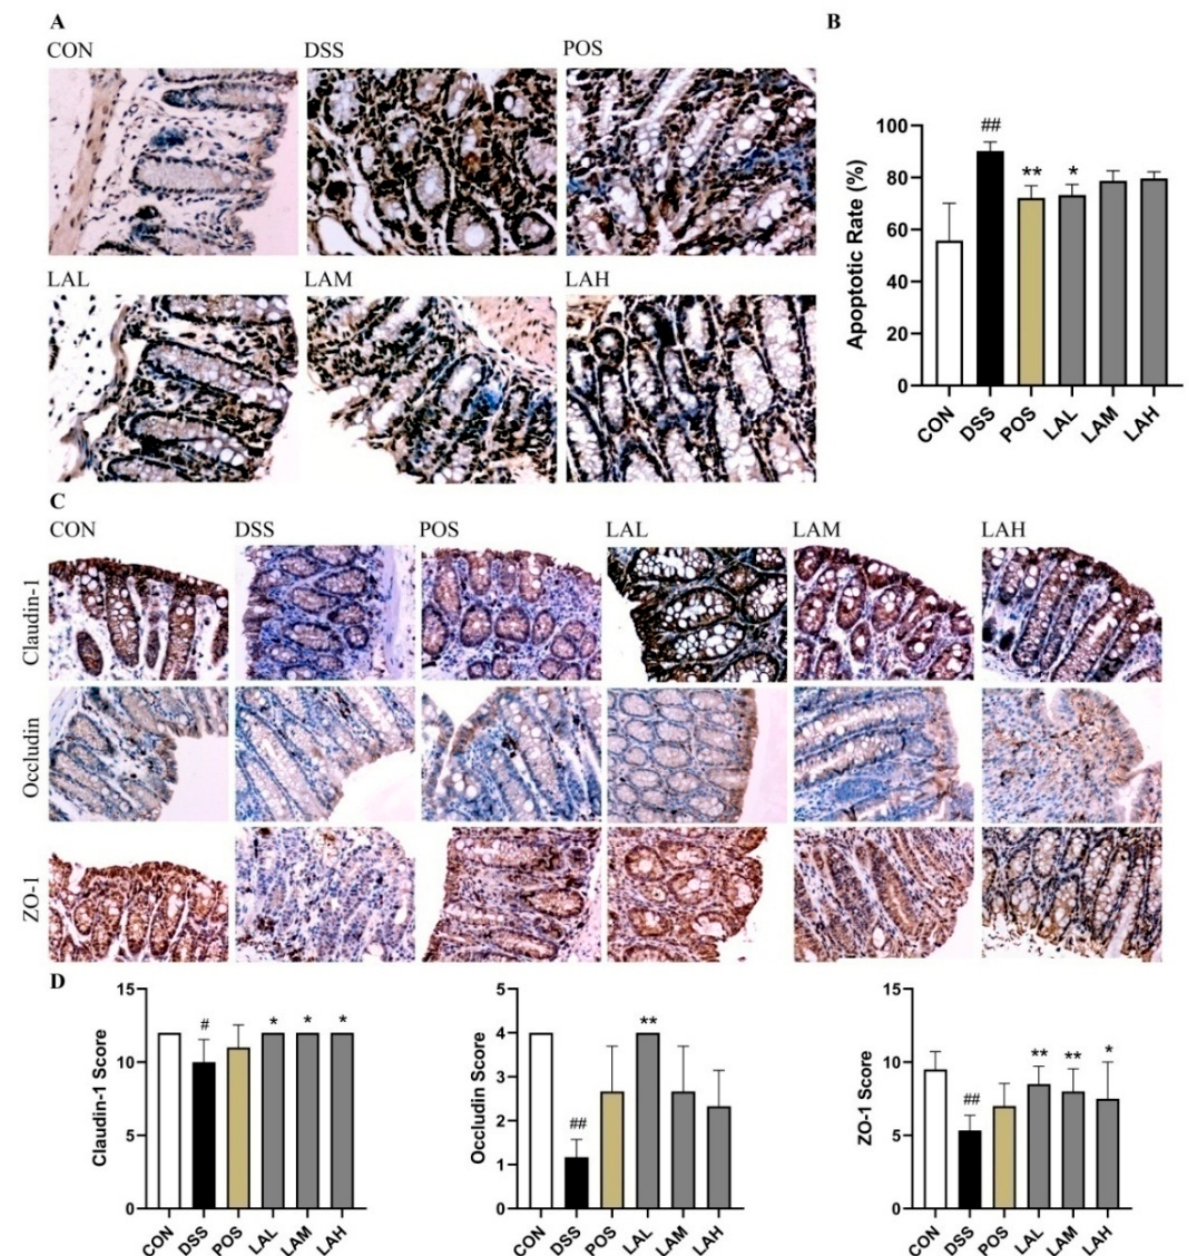
Figure 2. LA preserved the gut barrier integrity in UC mice . ( A ) TUNEL assay images (200×). ( B ) Rate of epithelial cell (EC) apoptosis. ( C ) Immunohistochemistry images (200×). ( D ) Claudin-1, occludin, and ZO-1 scores. Data are expressed as mean ± SD ( n = 6); # p < 0.05 and ## p < 0.01 vs. CON, * p < 0.05 and ** p < 0.01 vs. DSS.